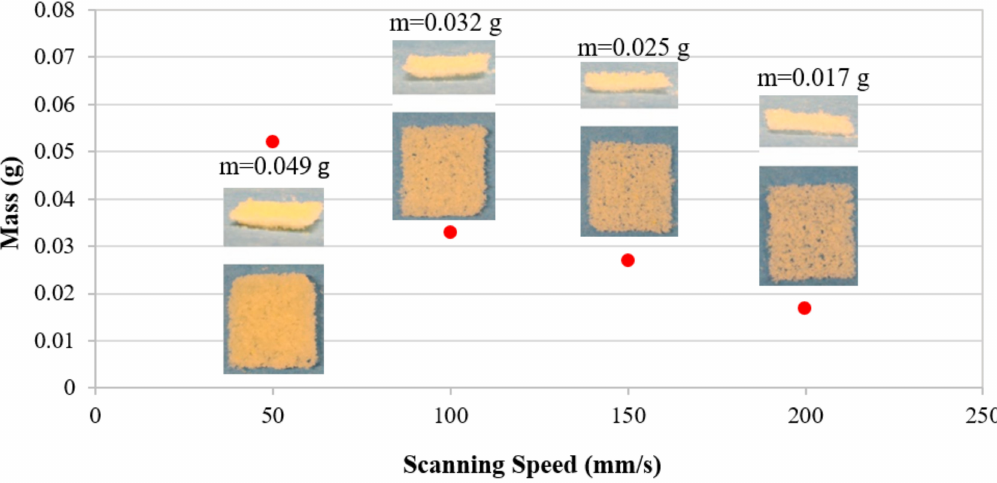
Figure 9. The e ff ect of laser scanning speed on the amount of fused material and distortion of 1 cm primitive layers. The process was performed at a constant power of 5.36 W, focal distance = 51 mm, and line spacing = 100 µ m. The images on the graph show the side and top view of the primitive